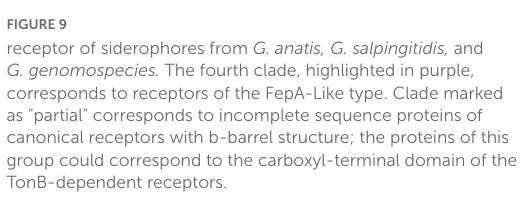
FIGURE9 receptor of siderophores from G. anatis, G. salpingitidis, and G. genomospecies. The fourth clade, highlighted in purple, corresponds to receptors of the FepA-Like type. Clade marked as "partial" corresponds to incomplete sequence proteins of canonical receptors with b-barrel structure; the proteins of this group could correspond to the carboxyl-terminal domain of the TonB-dependent